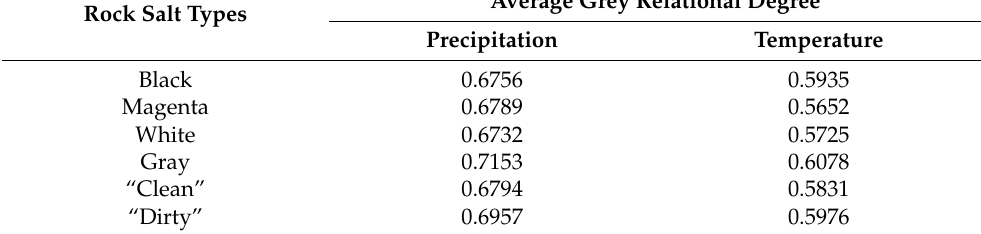
Table 7. The average grey relational degree between the absolute value of time series displacement of different rock salt, precipitation, and temperature during the Sentinel-1A image acquisition time interval. Average Grey Relational Degree Rock Salt Types Precipitation Temperature Black 0.6756 0.5935 Magenta 0.6789 0.5652 White 0.6732 0.5725 Gray 0.7153 0.6078 “Clean” 0.6794 0.5831 “Dirty”